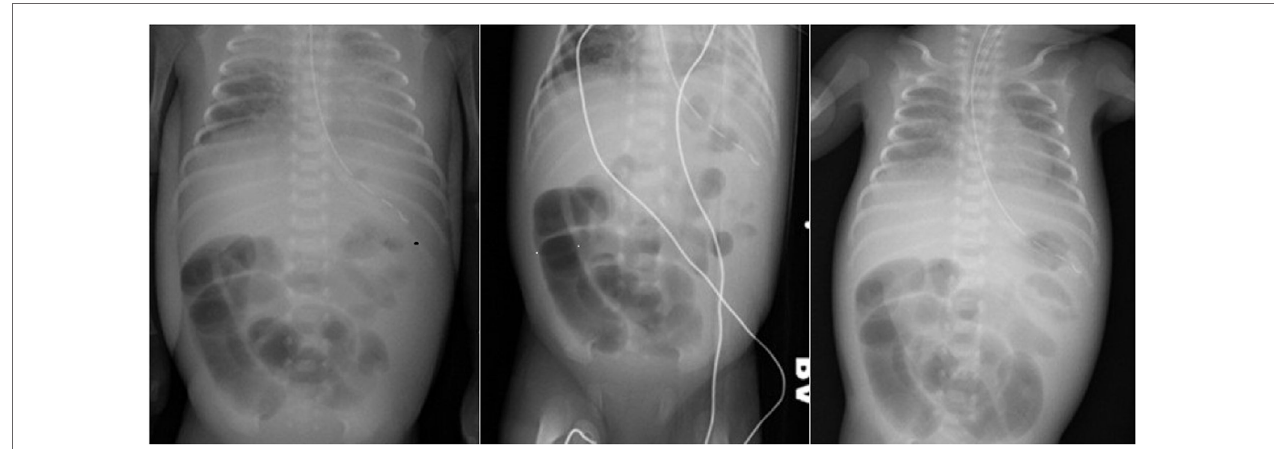
FIGURe1 | Left pane—plain AP radiograph of chest and abdomen with dilated loops of bowel. Central pane—plain left lateral decubitus radiograph of abdomen with dilated bowel loops and no evidence of pneumoperitoneum. Right pane—sequential AP radiograph of abdomen showing fixed dilated “sentinel”